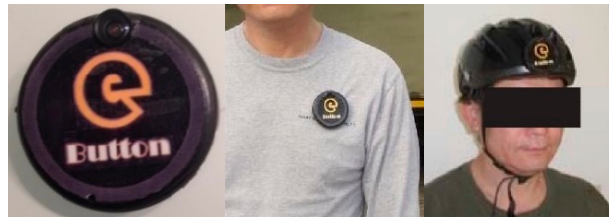
Figure 9. Appearance and two possible ways to wear the eButton device.